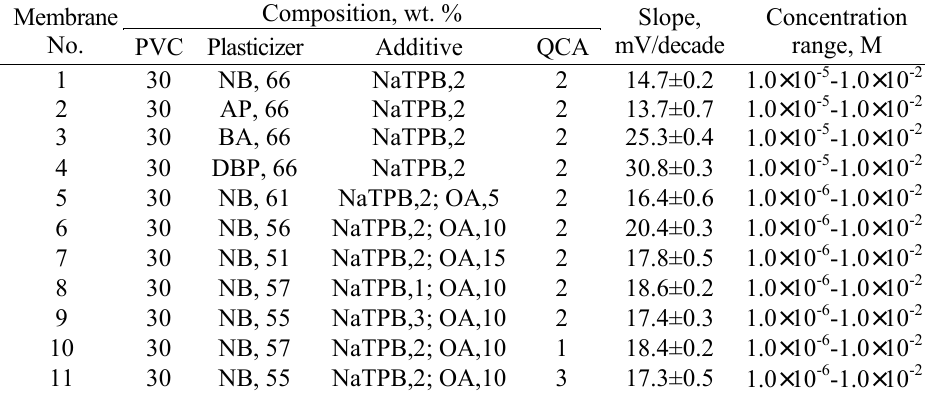
Table 1. Composition of membrane ingredients Composition, wt. %